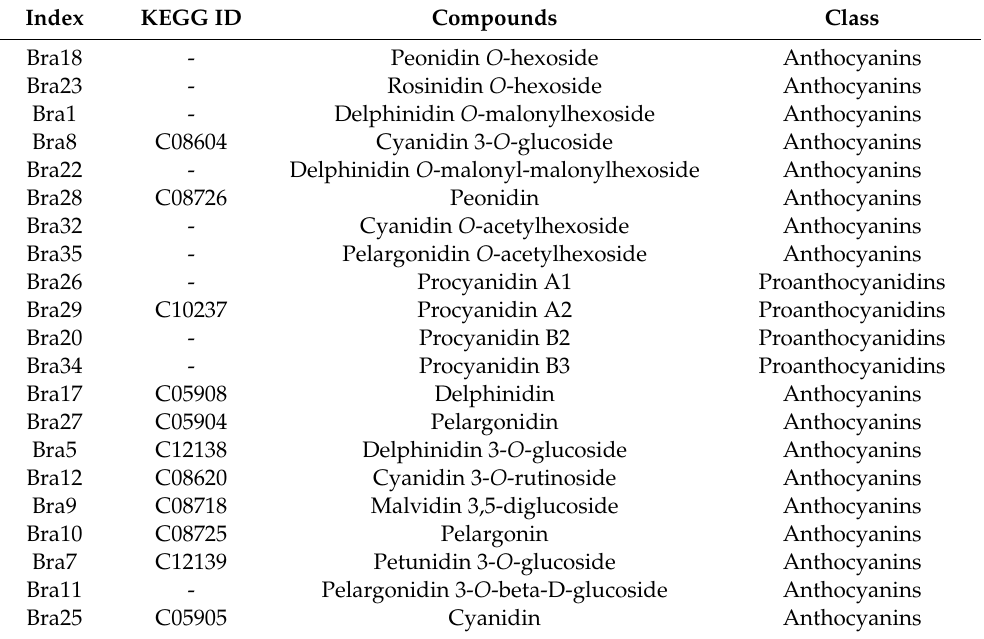
Table 4. Anthocyanins detected in two turnip